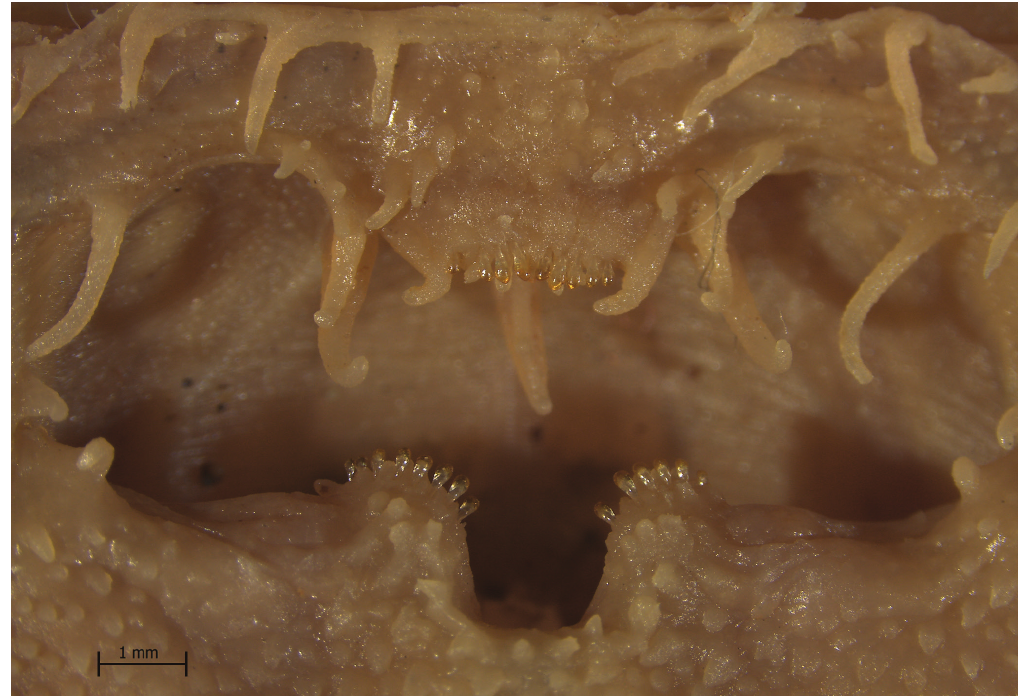
Fig. 3. Pseudohemiodon unillano , paratype, IAvH-P 19088, 183.2 mm SL. Detail of buccal ornamentation and teeth. Photograph by L. M. Mesa